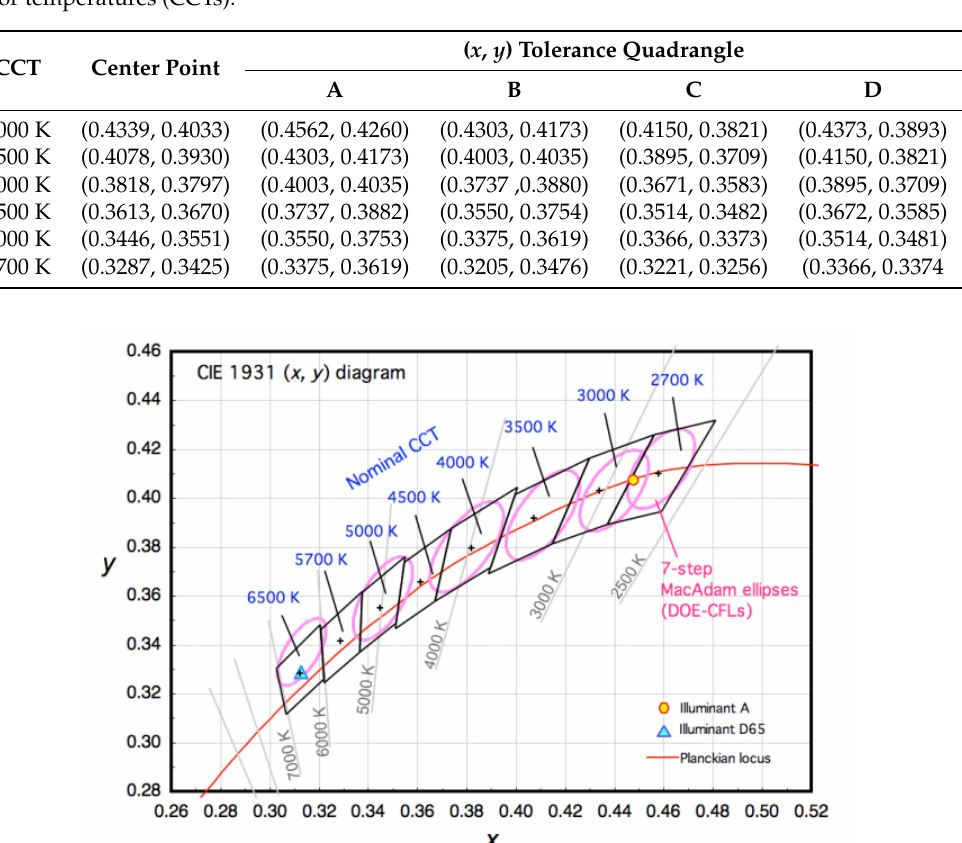
Figure 4. The chromaticity tolerance with quadrangle range for LED products in the CIE 1931 chromaticity Figure A1, Part 1 Graphical representation of the chromaticity specification of SSL products in Table 1, on the CIE (x,y ) chromaticity diagram